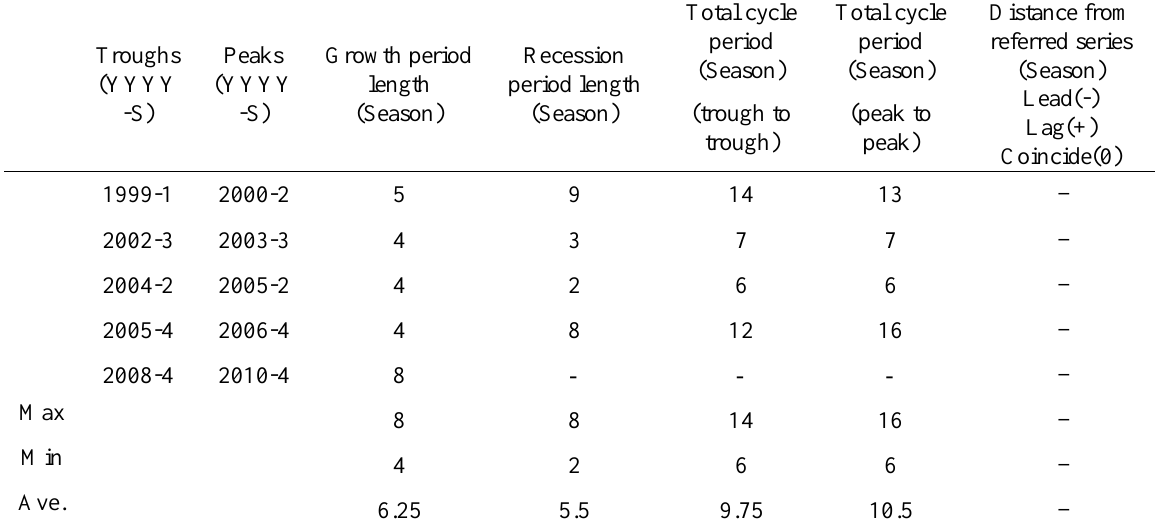
Table 3. Turning points of reference series Troughs